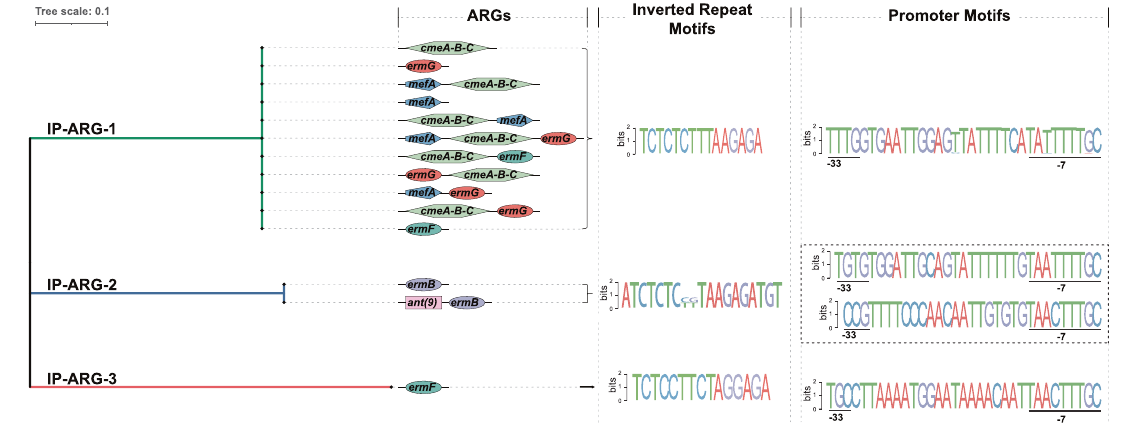
Fig. 1 Three classes of invertible promoters regulating ARGs (IP-ARG) (IP-ARG-1, IP-ARG-2, and IP-ARG-3). The ARGs and putative ARG organization patterns are shown for each class. Different ARGs are shown in different shapes and